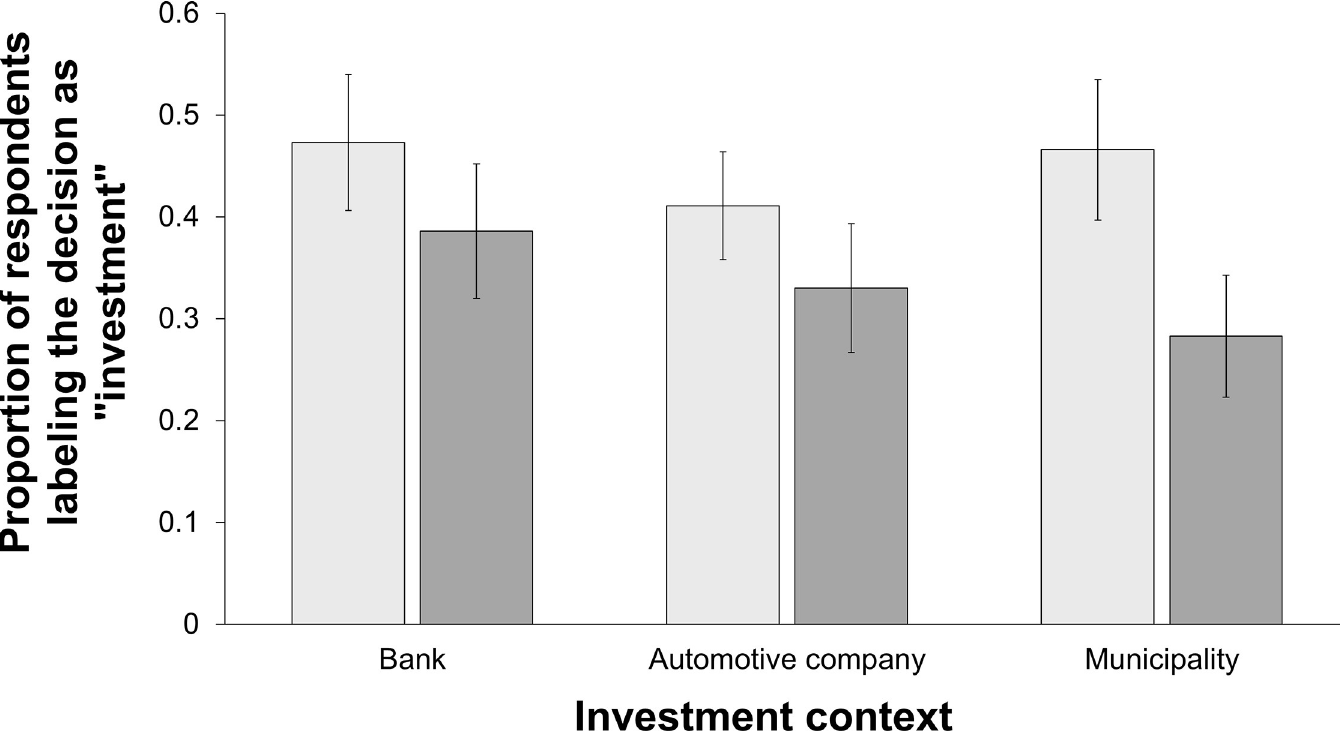
Fig 2. Proportion of respondents labeling the decision “investment” by outcome. Note: The light gray bars depict the profit case and the dark gray bars depict the loss case.